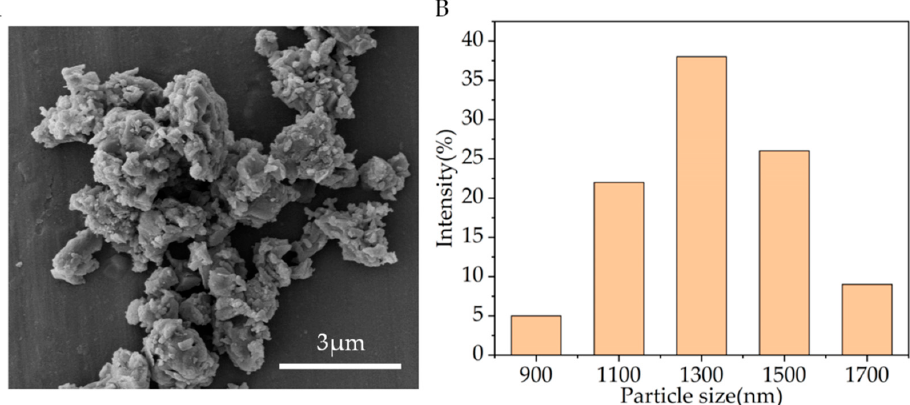
Figure 2. Characterization of the CSi-Mg powders. ( A ) SEM image of the CSi-Mg powders. ( B ) Particle size distribution of the powders. ( B ) Particle size distribution of the